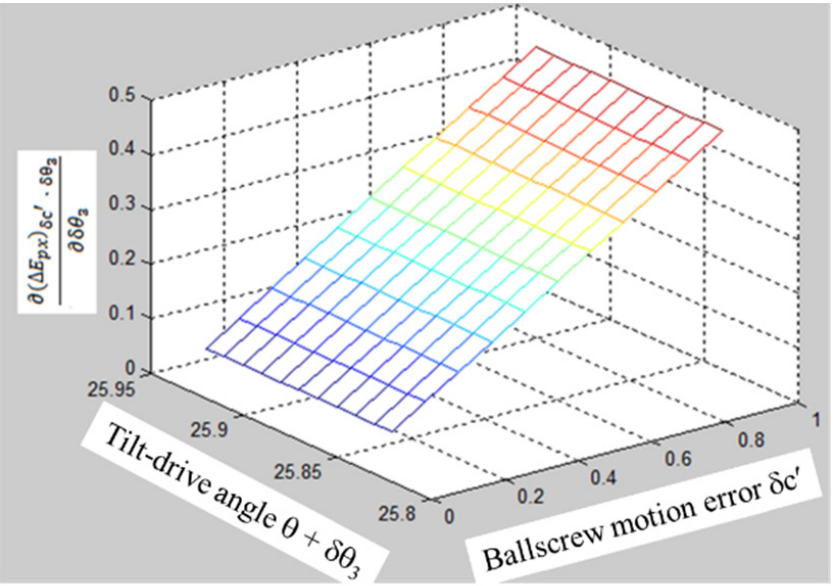
Figure 9. Relationship between the tilt-drive angle assembly error δ θ 3 and parameter